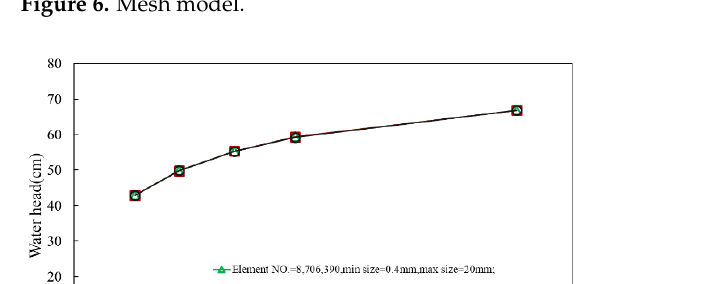
Figure 6. Mesh model.